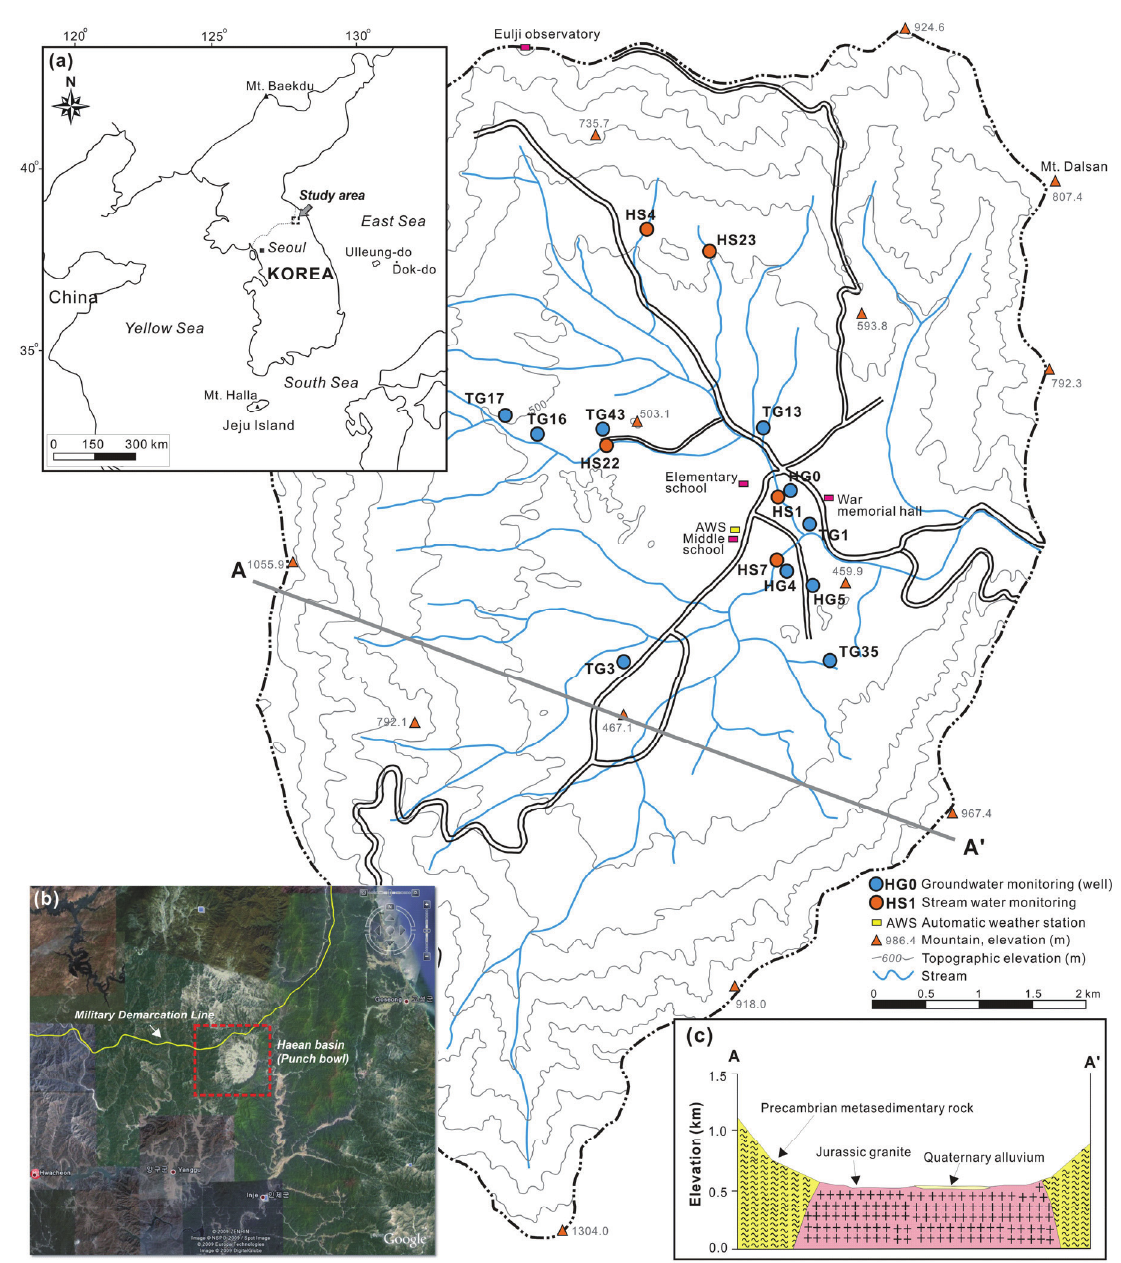
Figure 1. Map of the study area showing the monitoring points for stream and groundwater